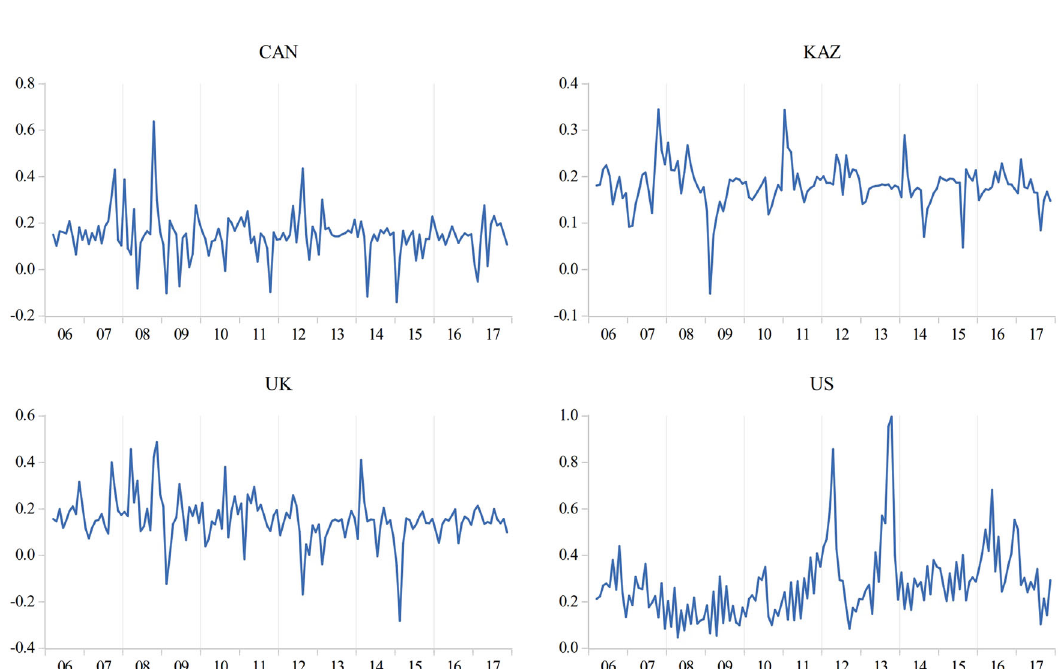
Fig. 4 Plots of dynamic correlation between global and local wheat prices.